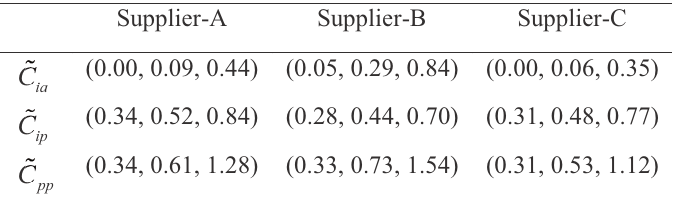
Table 4 The fuzzy indices for supplier